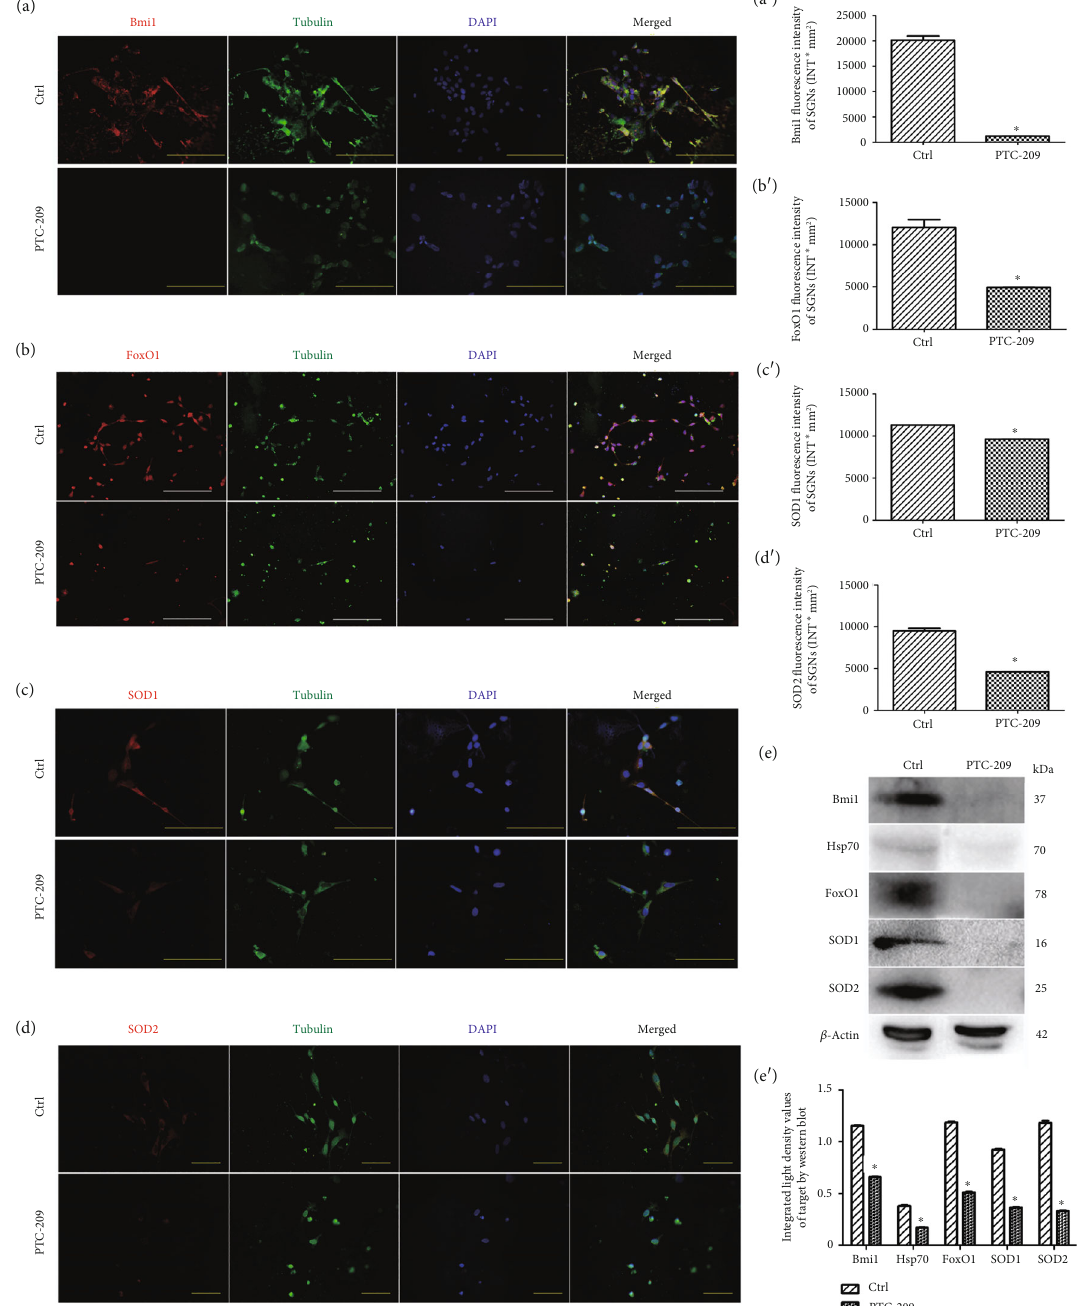
Figure 9: Bmi1, FoxO1, SOD1, and SOD2 expressions in SGNs after PTC-209 treatment. Distributions and expressions of Bmi1, FoxO1, SOD1, and SOD2 protein in SGNs were detected with the immune- fl uorescence assay in the control group and the PTC-209 treated groups (a – d), while the quantity of these protein expressions was analyzed by fl uorescence intensity (a ′ – d ′ ). After PTC-209 treatment, Bmi1/FoxO1/SOD1/SOD2 (red) and tubulin (green) as SGN marker were, respectively, labeled with fl uorescent secondary antibody and nuclei (blue) were labeled with DAPI. Scale bars represent 100 μ m and 50 μ m. Furthermore, values are means ± SD ( N = 40 animals from 2 groups). ∗ P < 0 : 05 vs. control group. Statistical analysis of the results presented in (a ′ – d ′ ) was performed with Student ’ s t -test ( ∗ P < 0 : 05 ; N = 40 animals from 2 groups). After PTC-209 treatment, protein expressions of Hsp70, Bmi1, FoxO1, SOD1, and SOD2 were assessed with western blot (e), while the quantity of these protein expressions was analyzed by integrated light density (e ′ ). β -Actin protein was available as an endogenous control. Furthermore, values are means ± SD . ∗ P < 0 : 05 vs. control group. Statistical analysis of the results was performed with two-way ANOVA (interaction: F ð 4, 20 Þ = 283 : 78 ; P < 0 : 0001 ; row factor: F ð 4, 20 Þ = 1276 : 15 ; P < 0 : 0001 ; column factor: F ð 1, 20 Þ = 7931 : 17 ; P < 0 : 0001 ), followed by Student ’ s t -test ( ∗ P < 0 : 05 ; n = 12